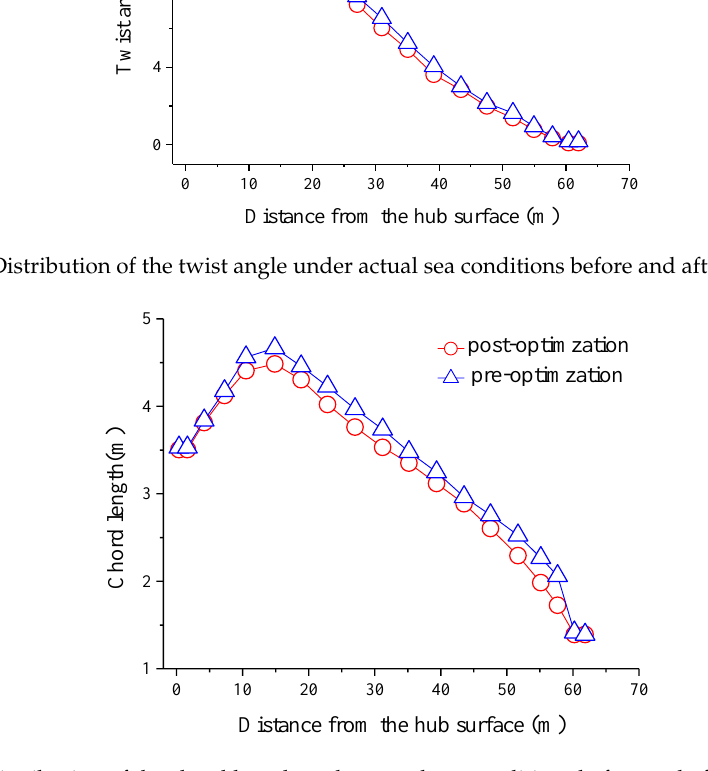
Figure 24. Distribution of the chord length under actual sea conditions before and after optimization.